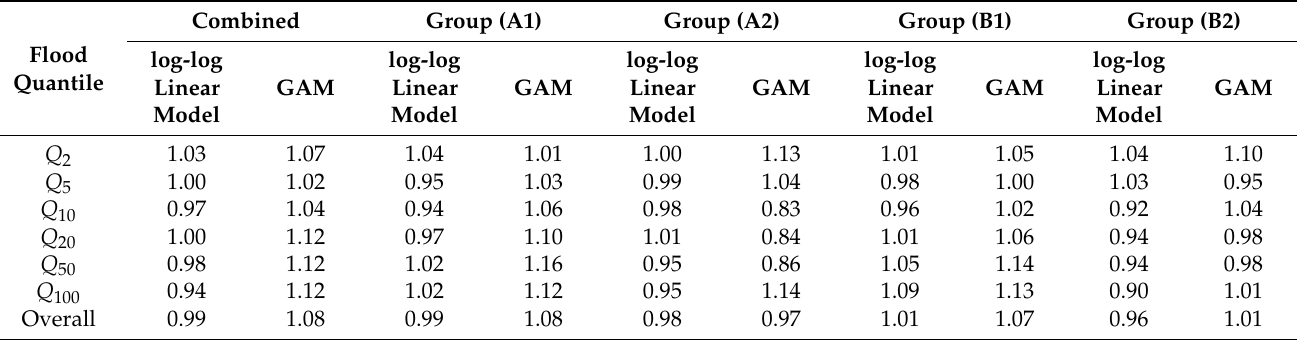
Table 6. Median Q pred / Q obs ratio values for the GAM and log-log linear model based RFFA techniques for 10